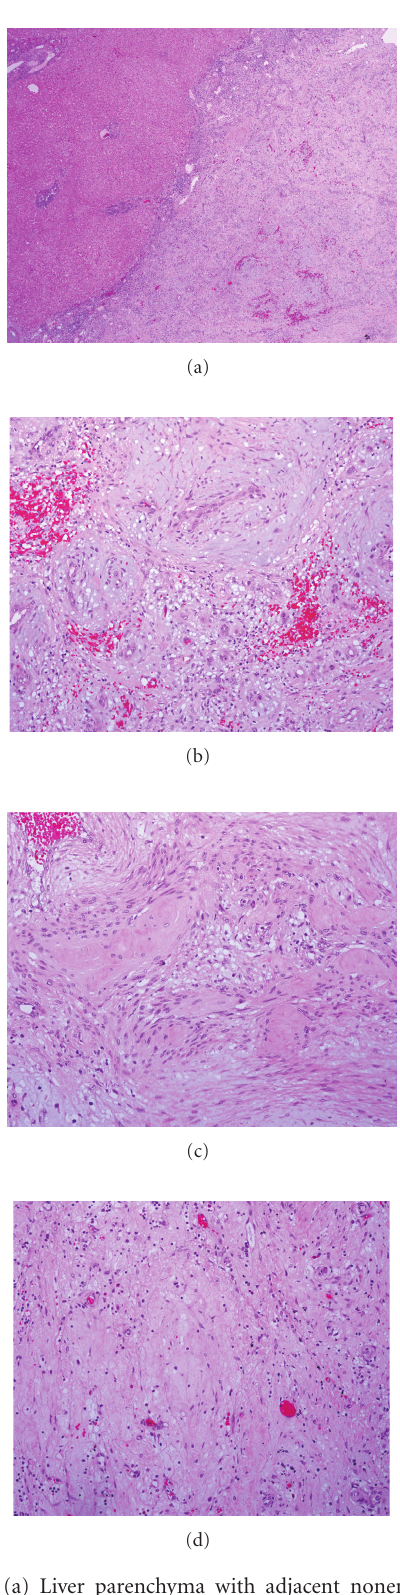
Figure 5: (a) Liver parenchyma with adjacent nonencapsulated mass (H&E, 20x), (b) tumor with a proliferation of thickened blood vessels with myxoid changes (H&E, 400x), (c) the hemangioma shows areas of hyalinized fibrosis (H&E, 400x), and (d) areas of loose connective tissue within the tumor (H&E,